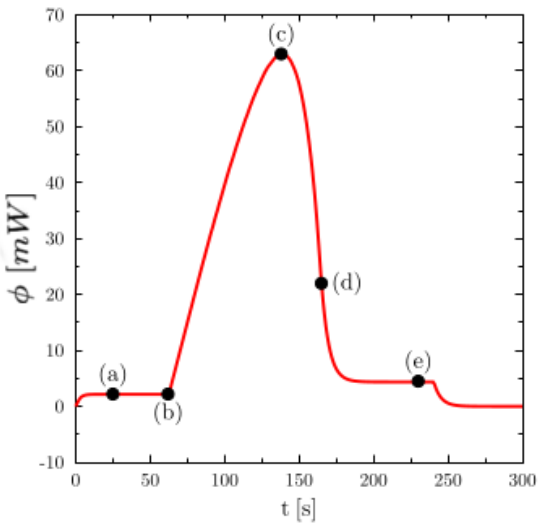
Figure 2. Typical thermogram of the melting of a pure